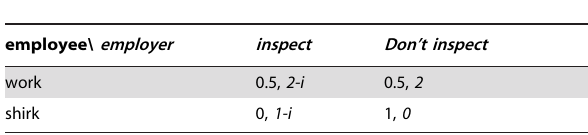
Table 2. Payoff matrix of the inspector